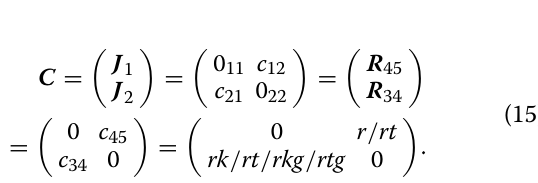
There are eight structural synthesis matrices, imply- ing that eight corresponding constrained metamorphic mechanisms can be theoretically designed to satisfy the broken strand repositioning operation. Finally, all eight structural diagrams for the repositioning metamorphic mechanisms are shown in Figure 16.